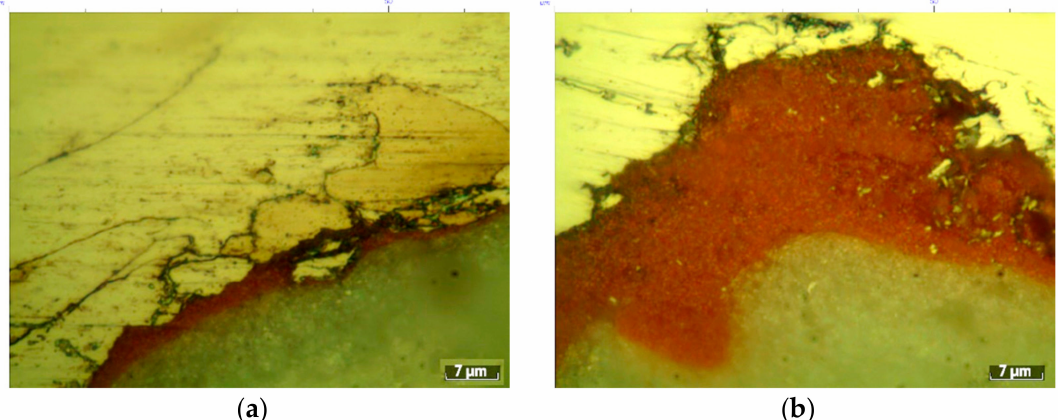
Figure 18. Defects at the metal-coating boundary: ( a ) cracks in the zone bordering the soil; ( b ) excessive thickness of the soil.